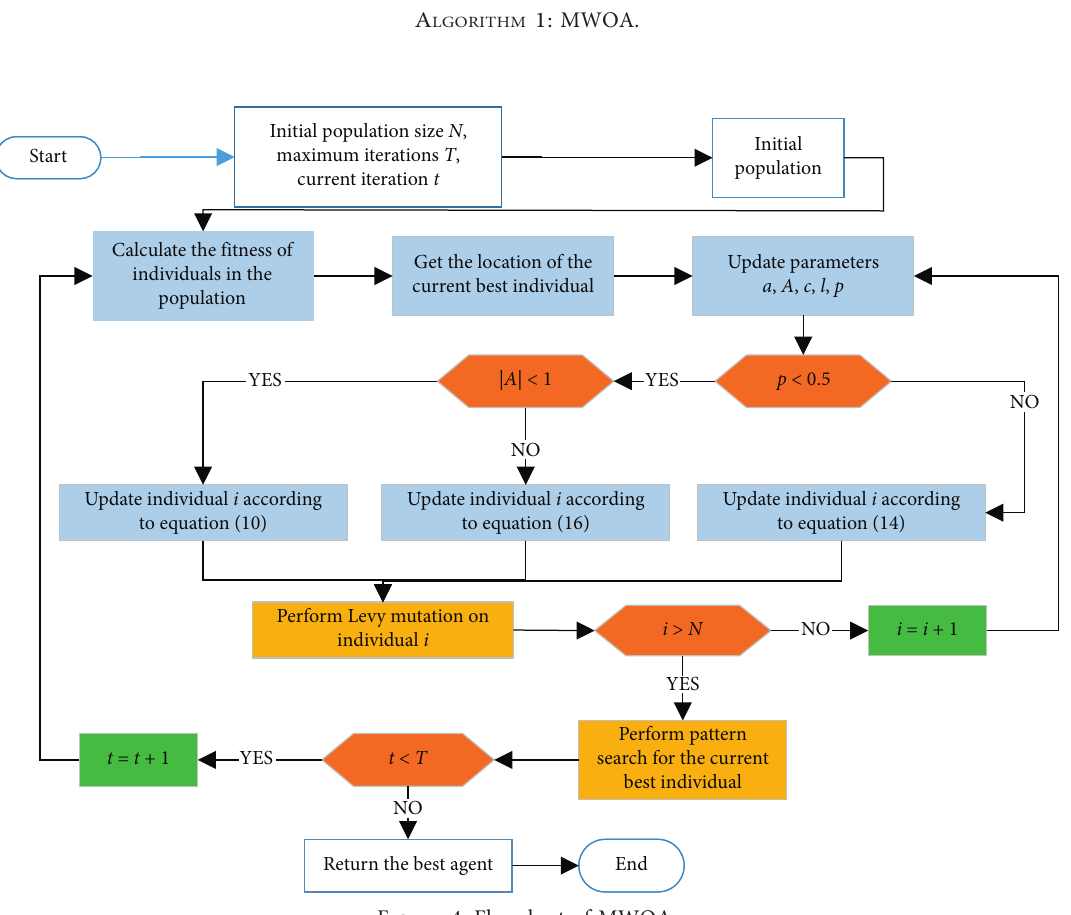
Figure 4: Flowchart of